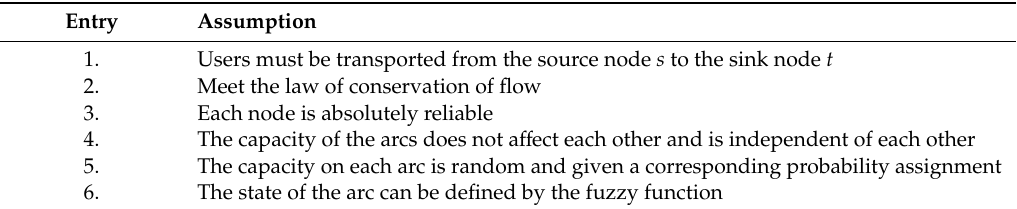
Table A1. Summary table of the